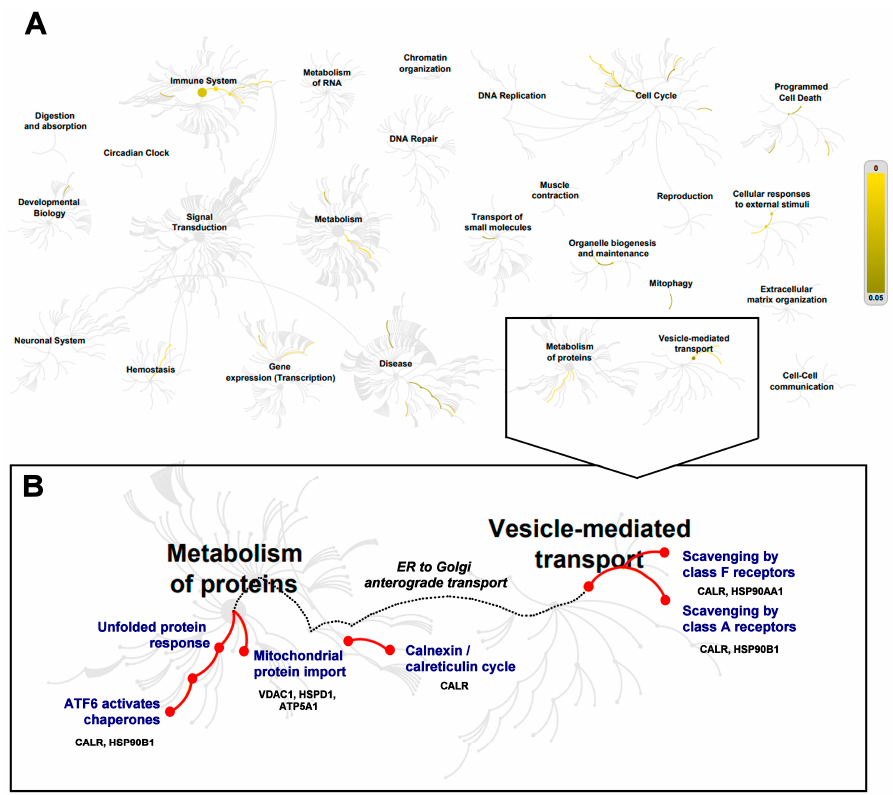
Figure 4. Reactome analysis of the 15 proteins differentially expressed in both SMA and ALS proteomic studies. ( A ) Genome-wide overview of Reactome pathway analysis identified several over-represented pathways (highlighted using a colored scale on the right-hand side that indicates false discovery rate (FDR)), including endoplasmic reticulum (ER) to Golgi anterograde transport [69], ( B ) Zoomed view of “metabolism of proteins” and “vesicle-mediated transport” pathways. Over-represented pathways are indicated by the red line. Proteins annotated to each pathway are shown.